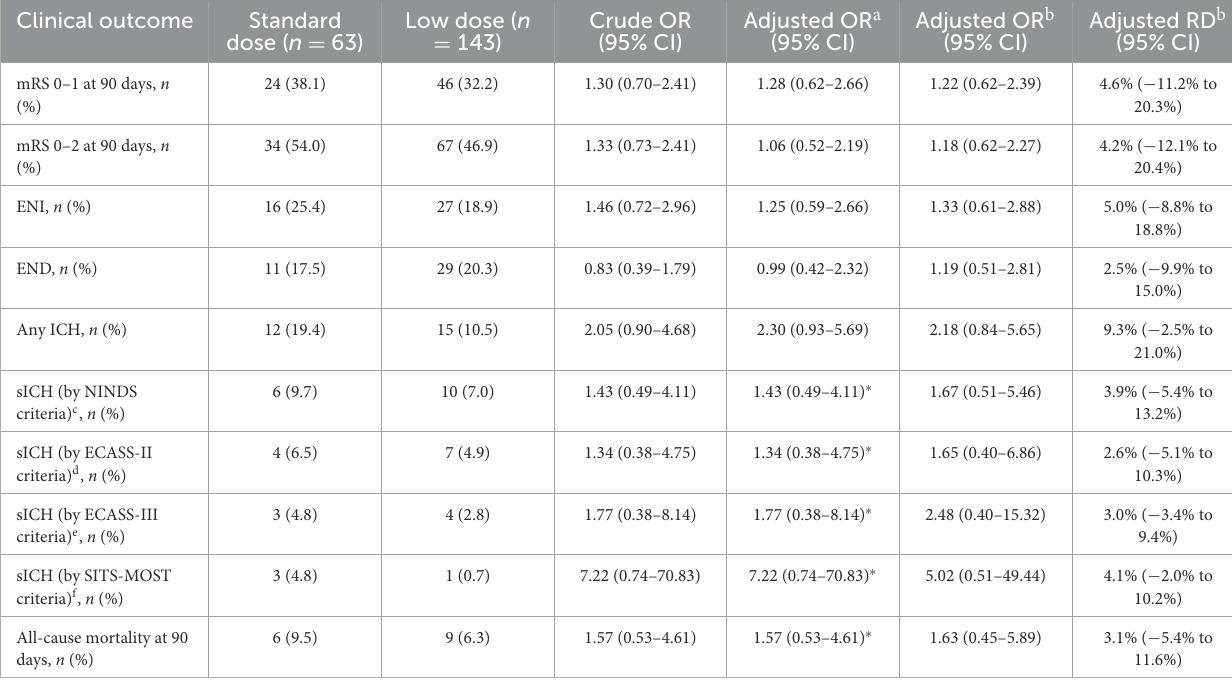
TABLE 3 Primary and secondary outcomes of patients treated with standard- vs. low-dose alteplase before and after PSM. Clinical outcome